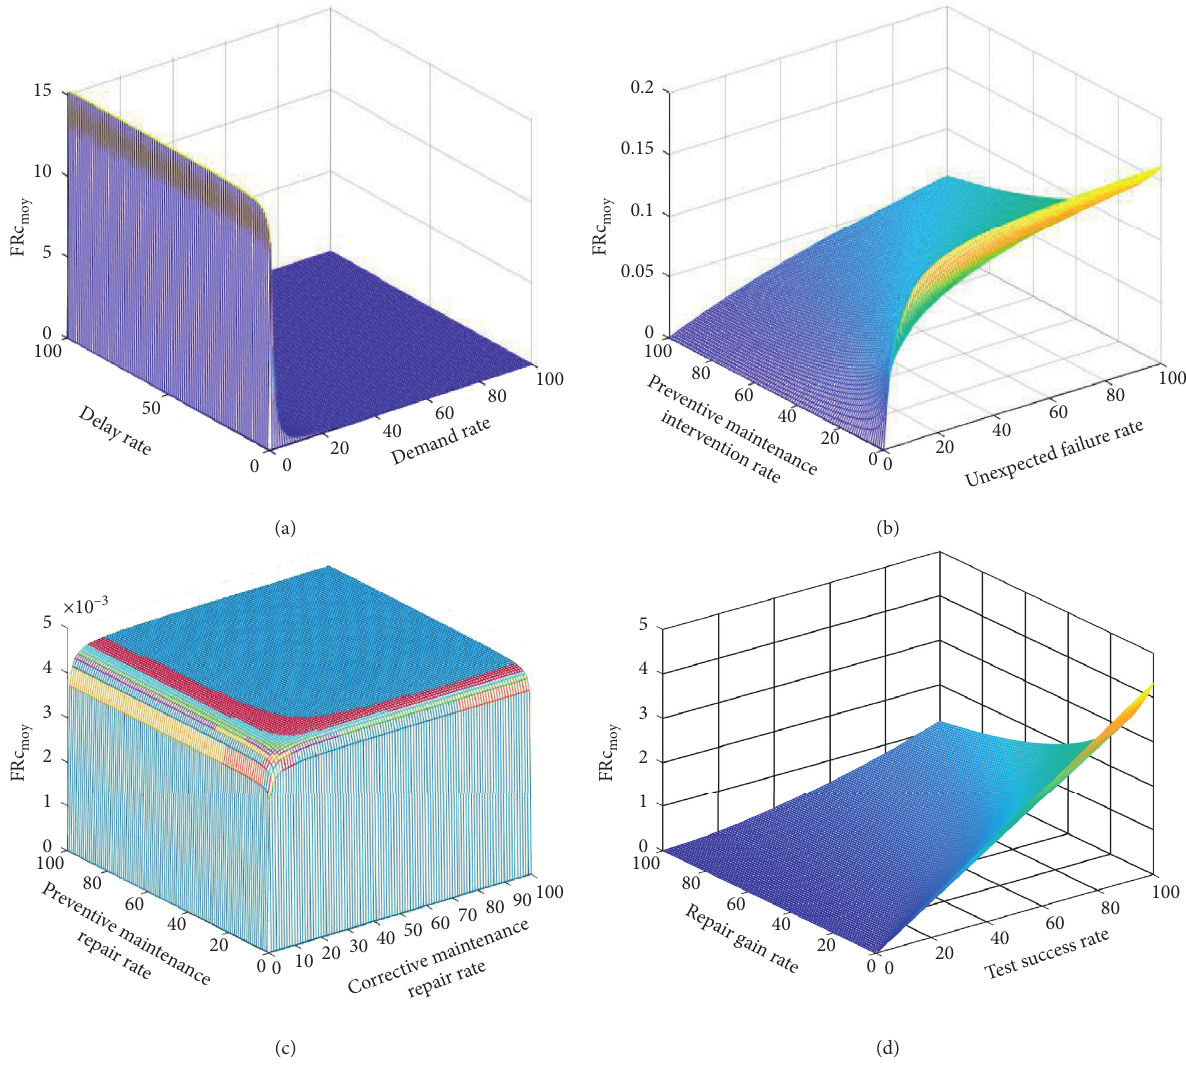
Figure 10: Corrective repair frequency. (a) Variation of demand and delay rates. (b) Rate variation of unexpected failure and maintenance interventions. (c) Repair rate variation for corrective and preventive maintenance. (d) Test rate variation (repair again or